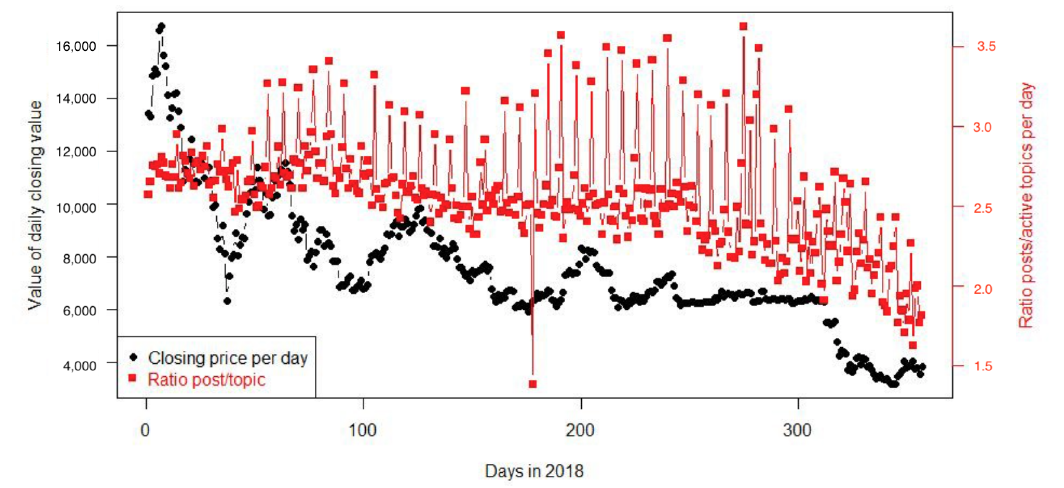
Figure 13. Comparison between the post/topic ratio and the daily closing value in